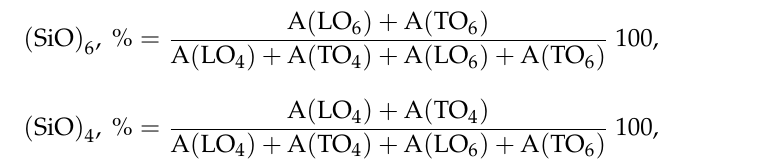
where A(LO 6 ) is the area of the band at 1220 cm − 1 , A(LO 4 ) is the area of the band at 1150 cm − 1 ; A(TO 4 ) is the area of the band at 1070 cm − 1 and A(TO 6 ) the area of the band at 1050 cm − 1